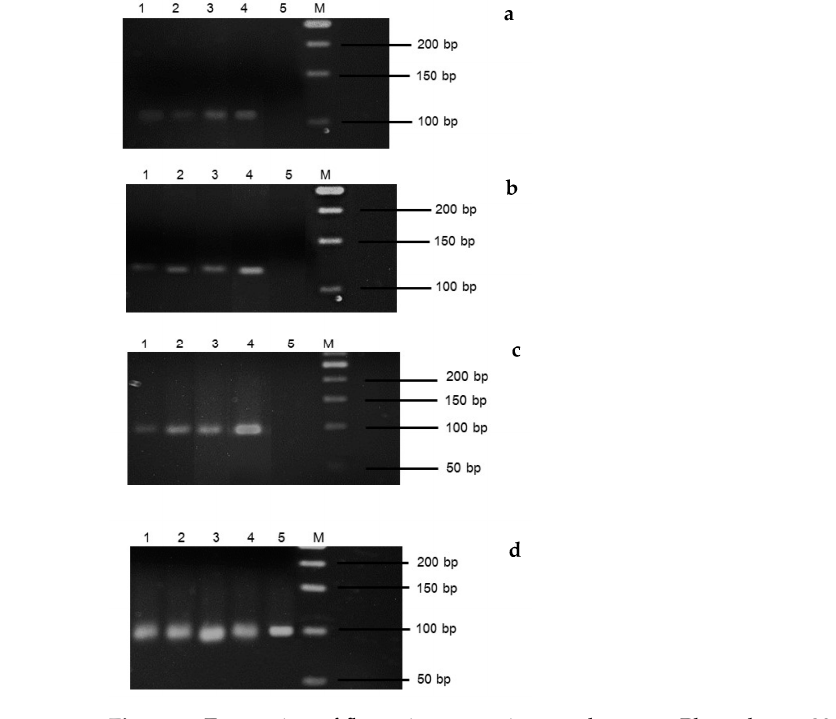
Figure 2. Expression of flowering genes in strawberry cv. Pharachatan 80 after vernalization. ( a ) FT, ( b ) SOC1, ( c ) VRN5, ( d ) UBISw (lane 1) 4 ◦ C for 1 week, (lane 2) 2 ◦ C for 1 week, (lane 3) 4 ◦ C for 2 weeks, (lane 4) 2 ◦ C for 2 weeks, (lane 5) no vernalization control, (lane M) DNA